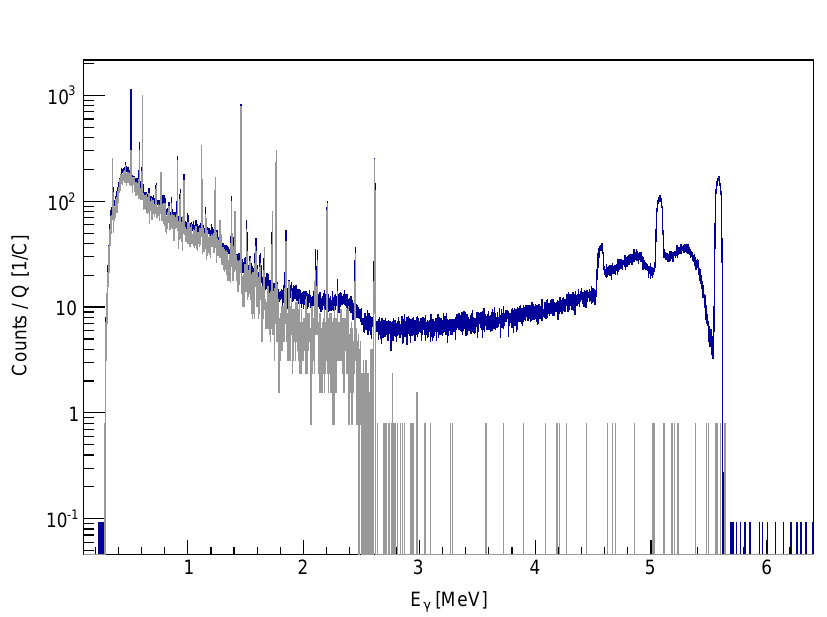
Figure 1: Typical γ -ray spectrum obtained with the HPGe detector at 150 keV beam energy: in blue the spectrum measured with D 2 gas and for comparison a beam induced background spectrum (grey) acquired with 4 He gas. The full-energy, single-escape and double-escape peaks from the D(p, γ ) 3 He reaction are clearly visible.